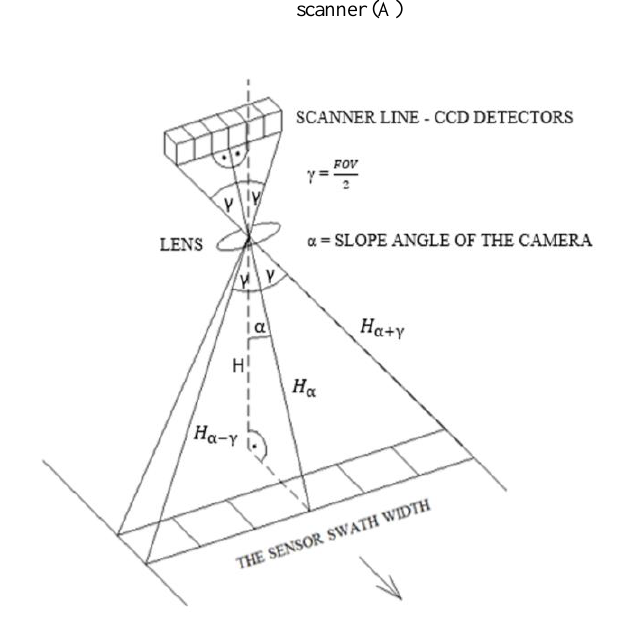
Figure 6. The diagram of image acquisition with electro- optic scanner